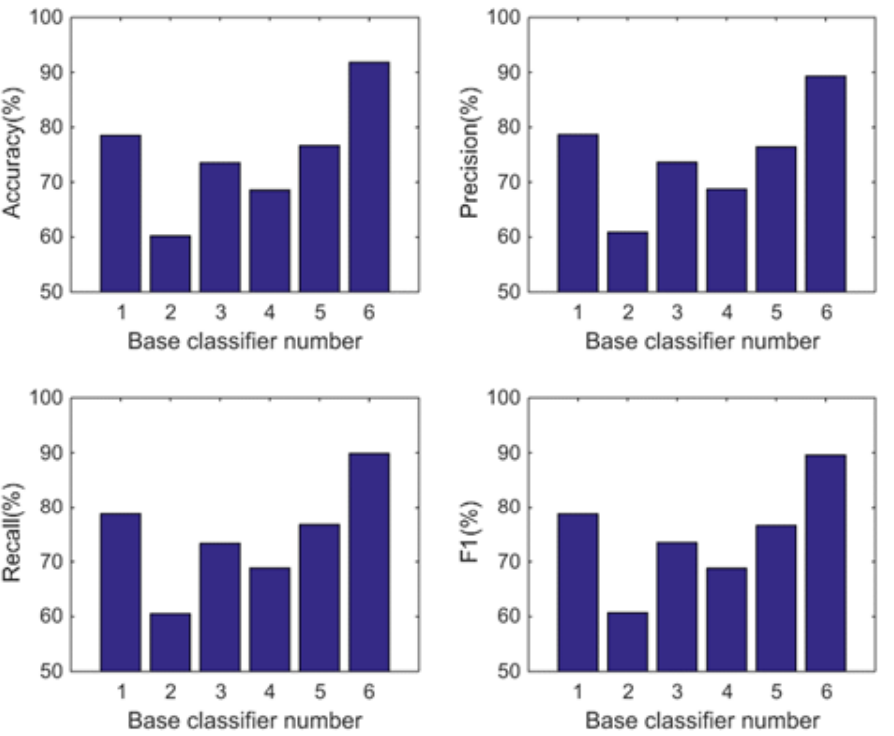
Figure 11. Performance comparison between base classifiers (1–5) and our fused classifier (6) for subject 2 in DSAD dataset.